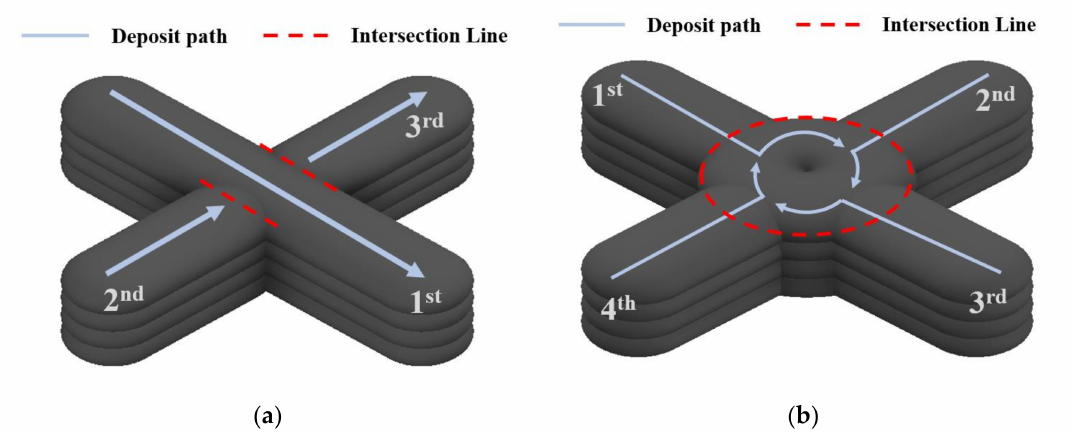
Figure 2. Conventional path planning methods for intersection part: ( a ) the divided path [23], ( b ) the circular path